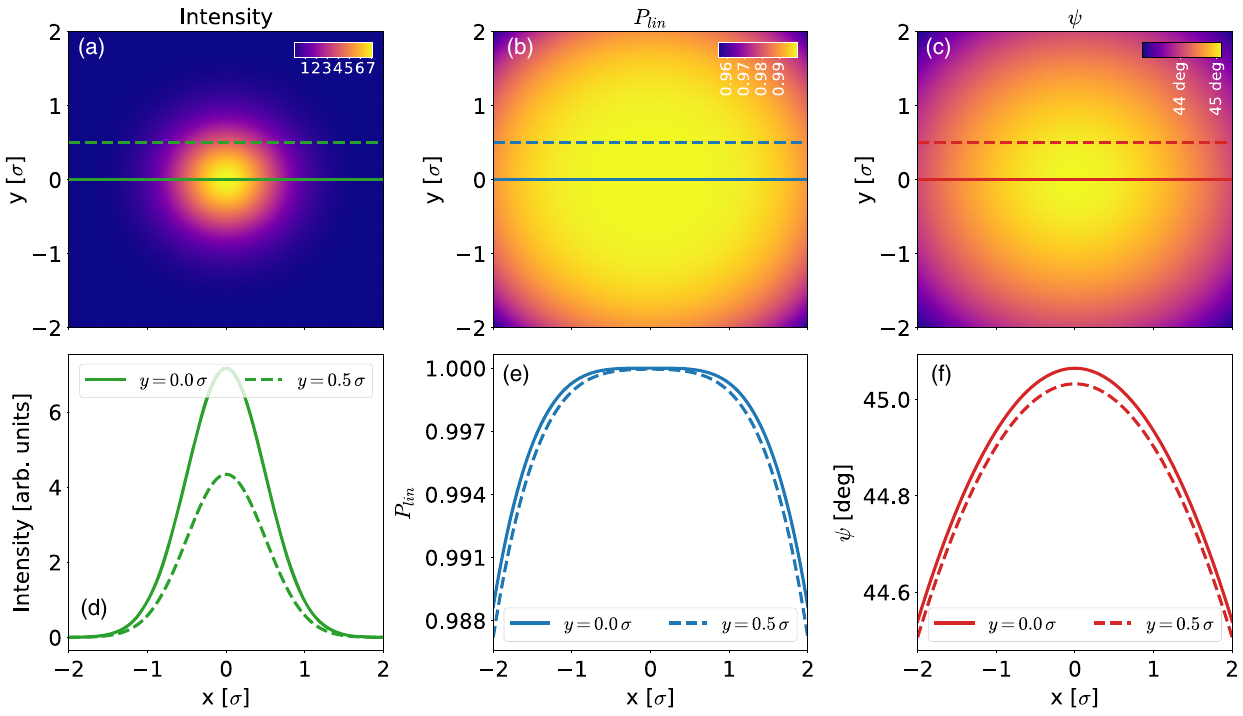
FIG. 5. False color representation of the far field intensity (a), degree (b) and direction (c) of linear polarization, for the superposition of two Gaussian beams with orthogonal polarization, namely linear horizontal and linear vertical, with phase shift an integer of the wavelength. The distance between the two sources is 0.03 z R . The above quantities are shown along the solid and dashed lines on the surfaces on the plots. The polarization properties of the radiation are in this case essentially constant along the wavefront of the